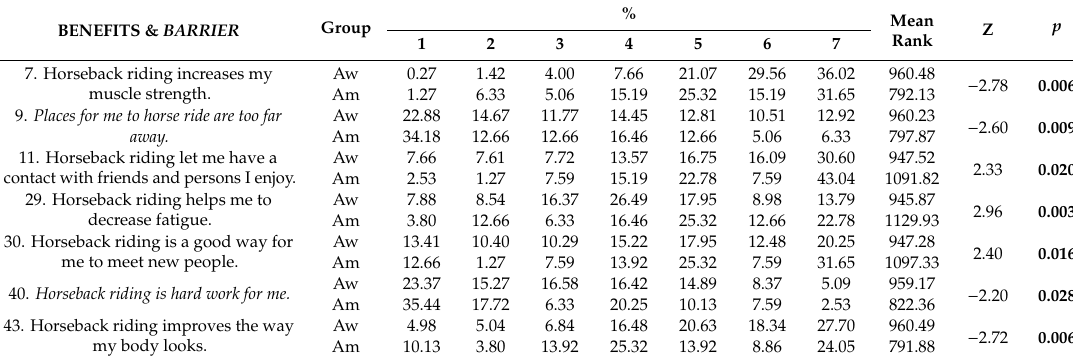
Table 8. Comparison of amateur group based on gender: women (n = 1827) vs men (n = 79), ( p < 0.05). (1–7 Likert scale: 1—this issue concerns me to a very low degree; 7—this issue concerns me to a very high degree).